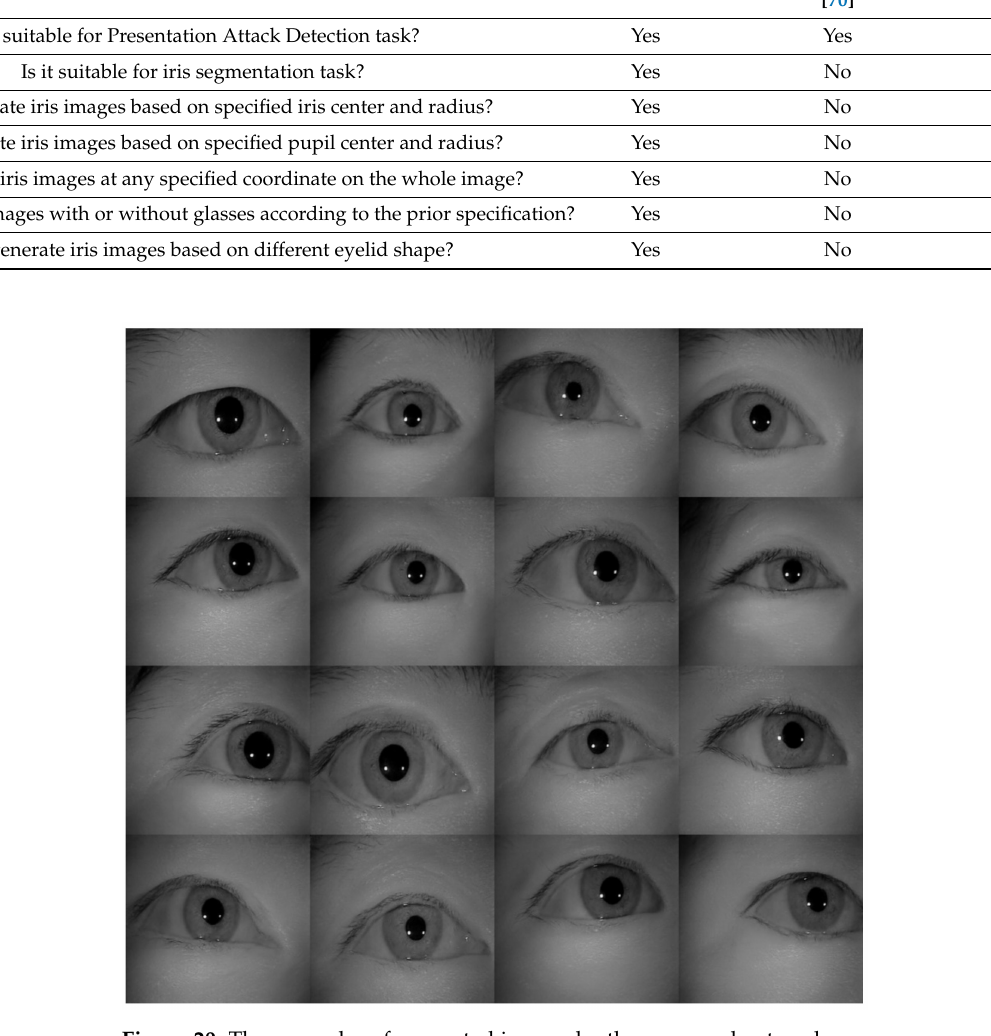
Figure 20. The examples of generated images by the proposed